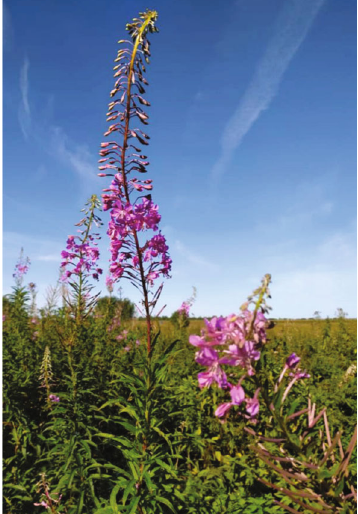
Figure 1: Chamaenerion angustifolium ( fi